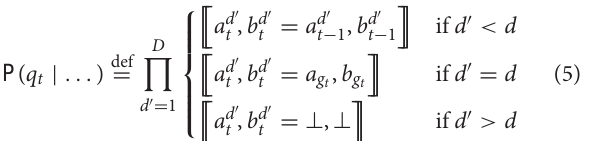
= 0) operations, creating new apex a g t